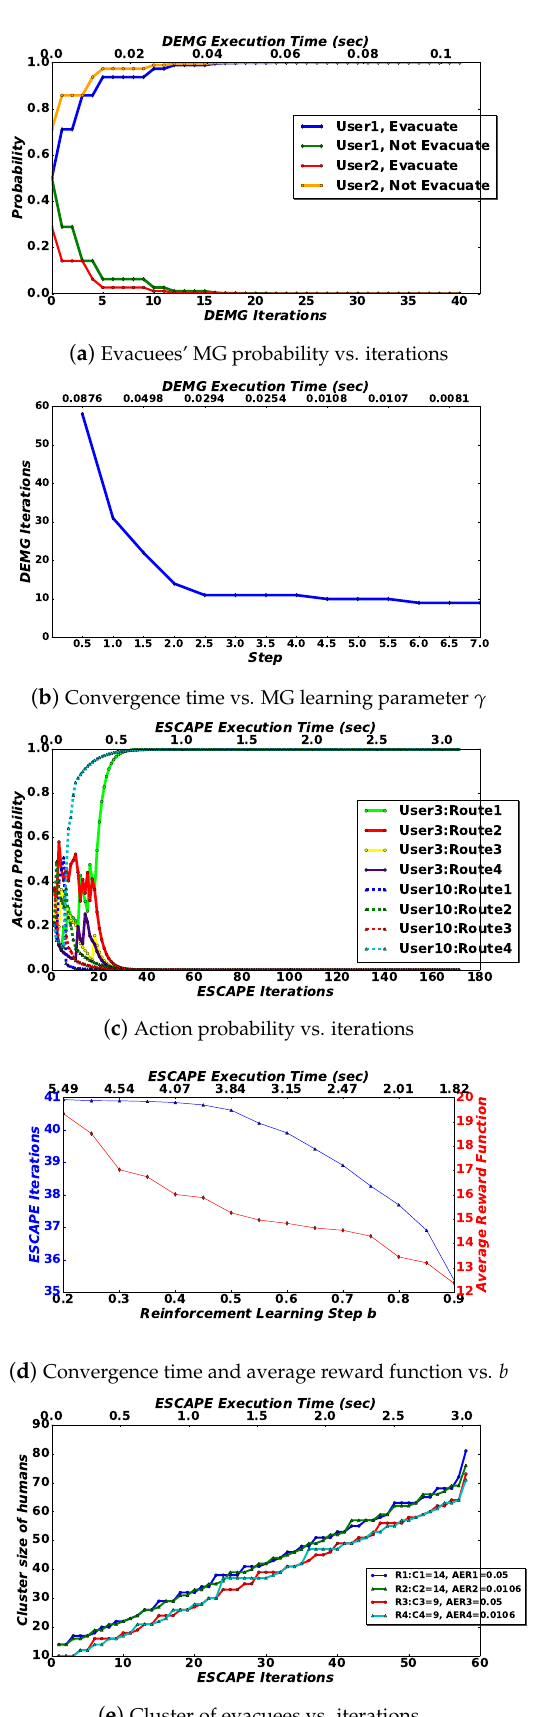
Figure 3. Pure operation of the proposed